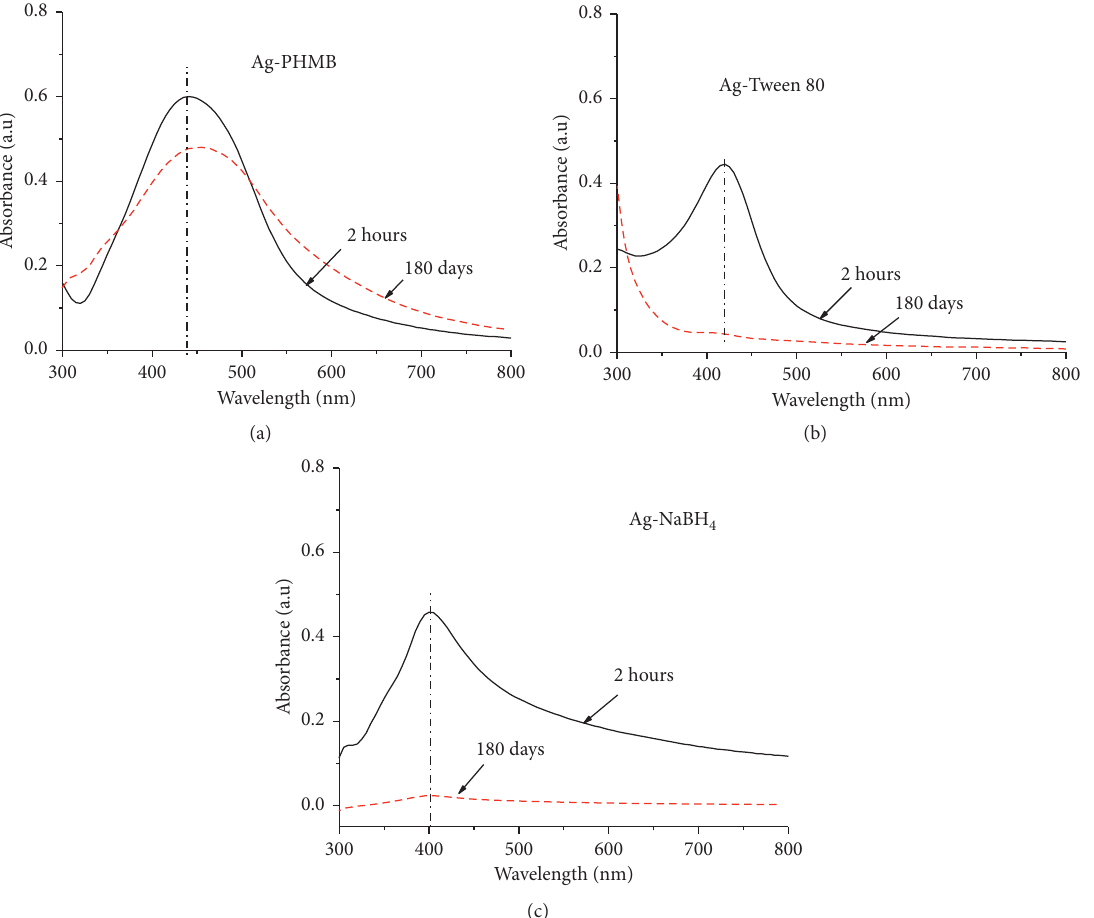
Figure 3: UV-Vis absorbance spectrum of the colloidal Ag-NPs stabilized by (a) PHMB, (b) Tween 80, and (c) NaBH